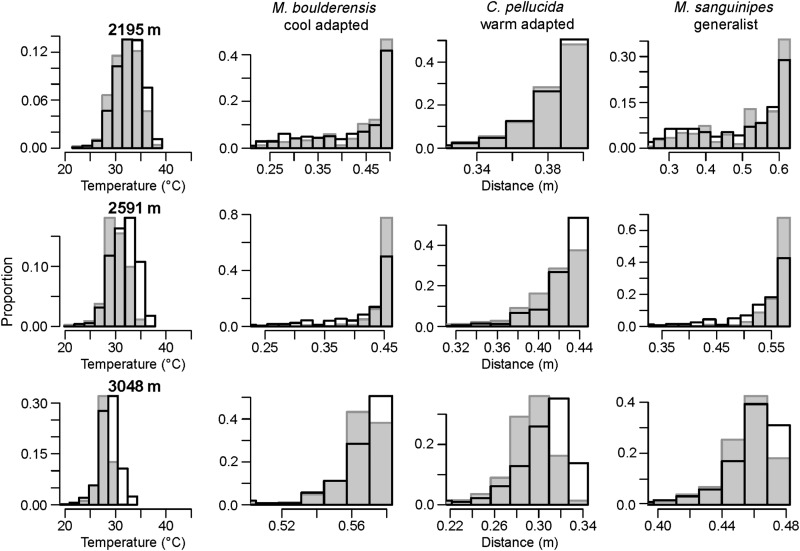
Histrogram depictions of estimated hopping performance shifts corresponding to the changes in daily mean temperature (left panels) at sites along the elevation gradient. We compare 1955–1965 (grey bars) with 2000–2010 (open bars). Estimated shifts in distance (in metres) are depicted for the three species. Values are averaged across days over daylight hours between 15 June and 15 August.